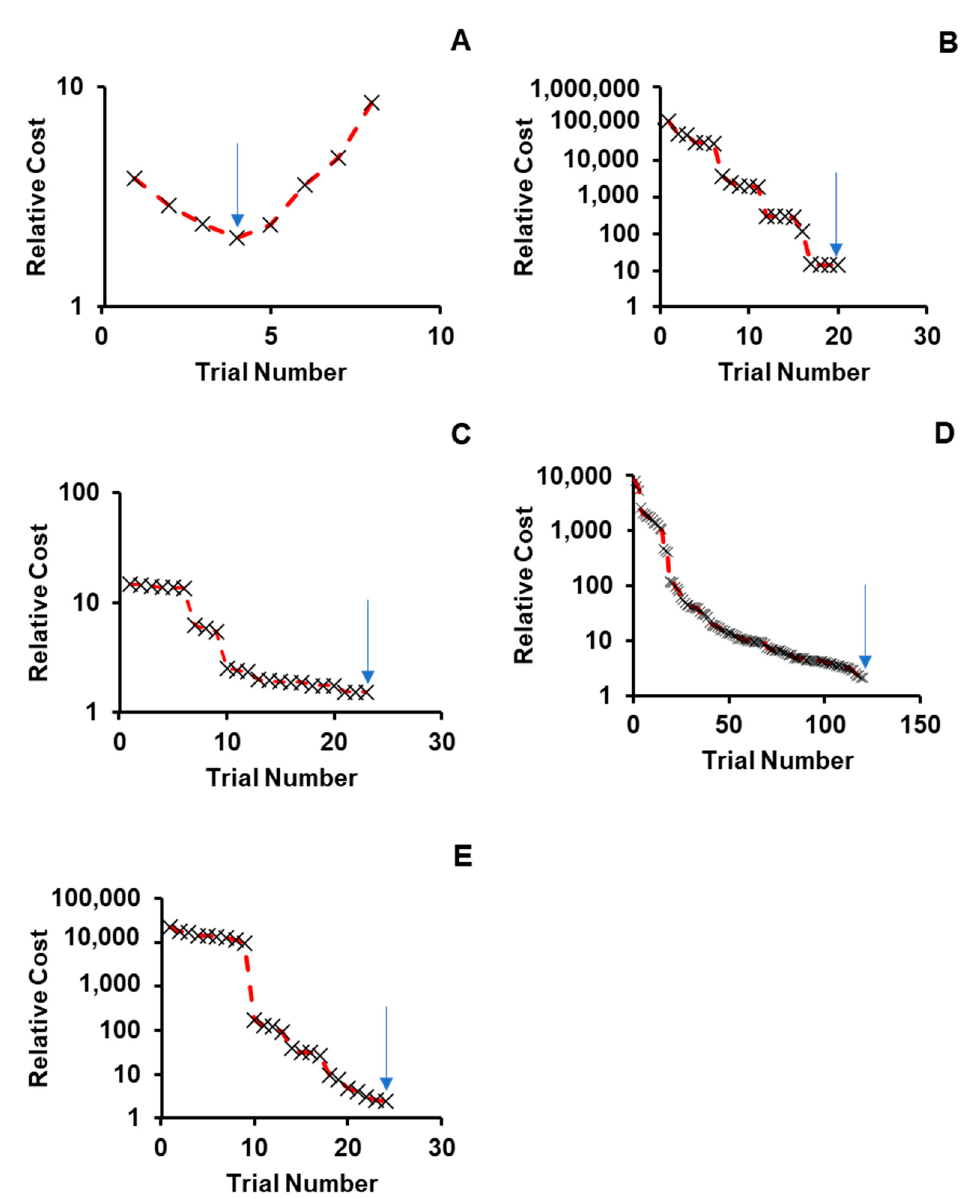
Figure 2. Convergence onto discrete parameter combinations during coarse optimization for ( A ) Verapamil, ( B ) Spirapril, ( C ) Lisinopril, ( D ) Lacidipine, and ( E ) Captopril. Relative cost on the y-axis is calculated as: Cost_relative = AAFEC-max*AAFEtmax*AAFEAUC where AAFECmax, AAFEtmax, AAFEAUC—absolute average fold error for Cmax, Tmax and AUC Table 3. Background on datasets used for systemic plasma-venous compartment disposition simulation and optimization of missing PK parameters.